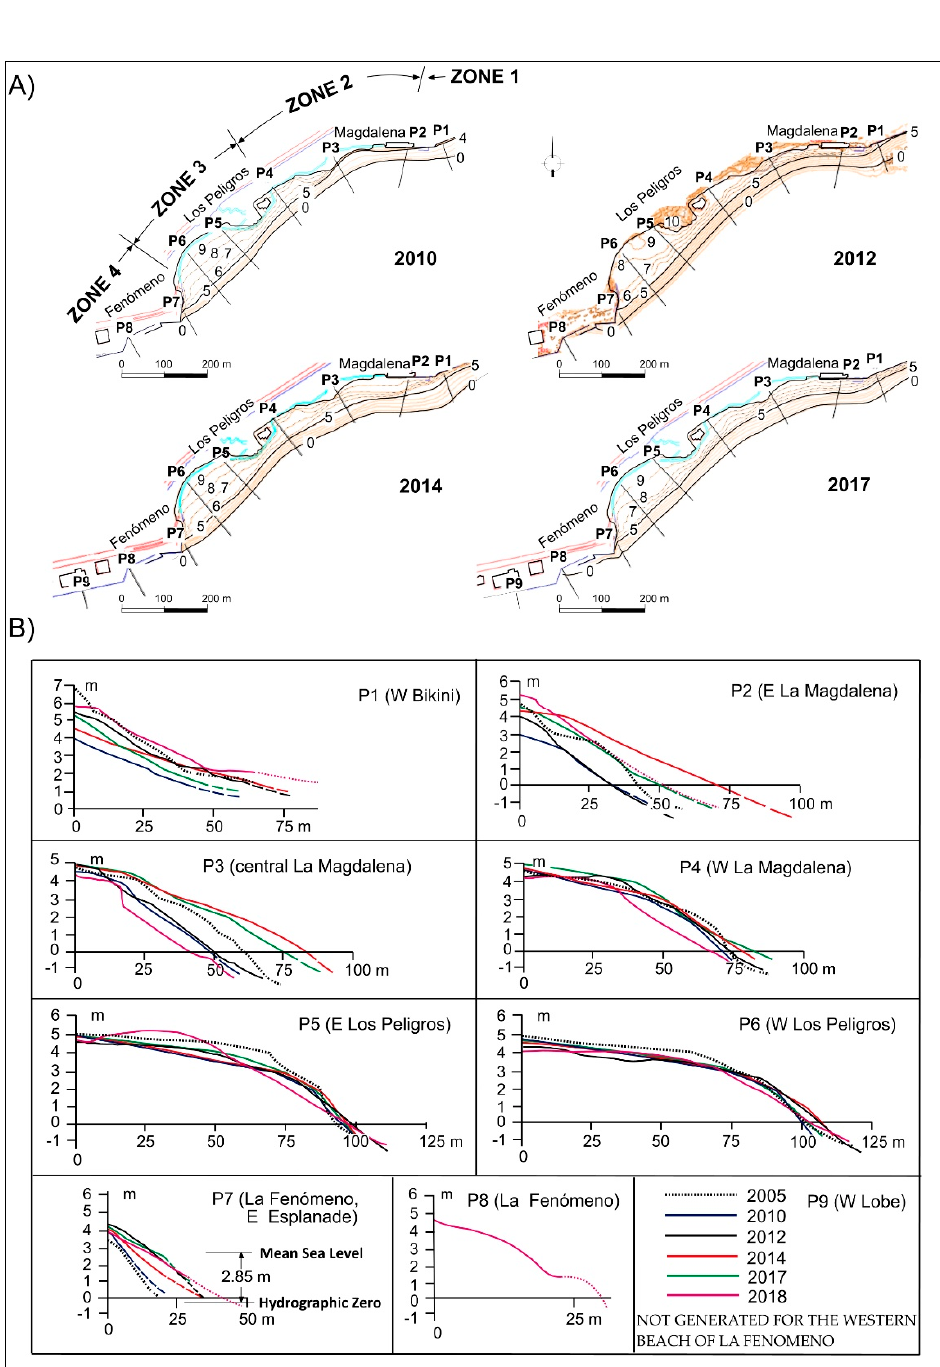
Figure 5. ( A ) Los Peligros and La Magdalena in 2005 (only the transverse profiles), 2010, 2012 (LiDAR), 2014 and 2017 from aerial photographs. The highest contour lines of +5 m are highlighted. ( B ) Nine overlapping longitudinal profiles (P1-P9) representative of the years 2005, 2010, 2012 (LiDAR), 2014, 2017 (some of which have been prolonged at its lower end) and 2018 (TLS), which aid in understanding the evolution of the emerged beaches.